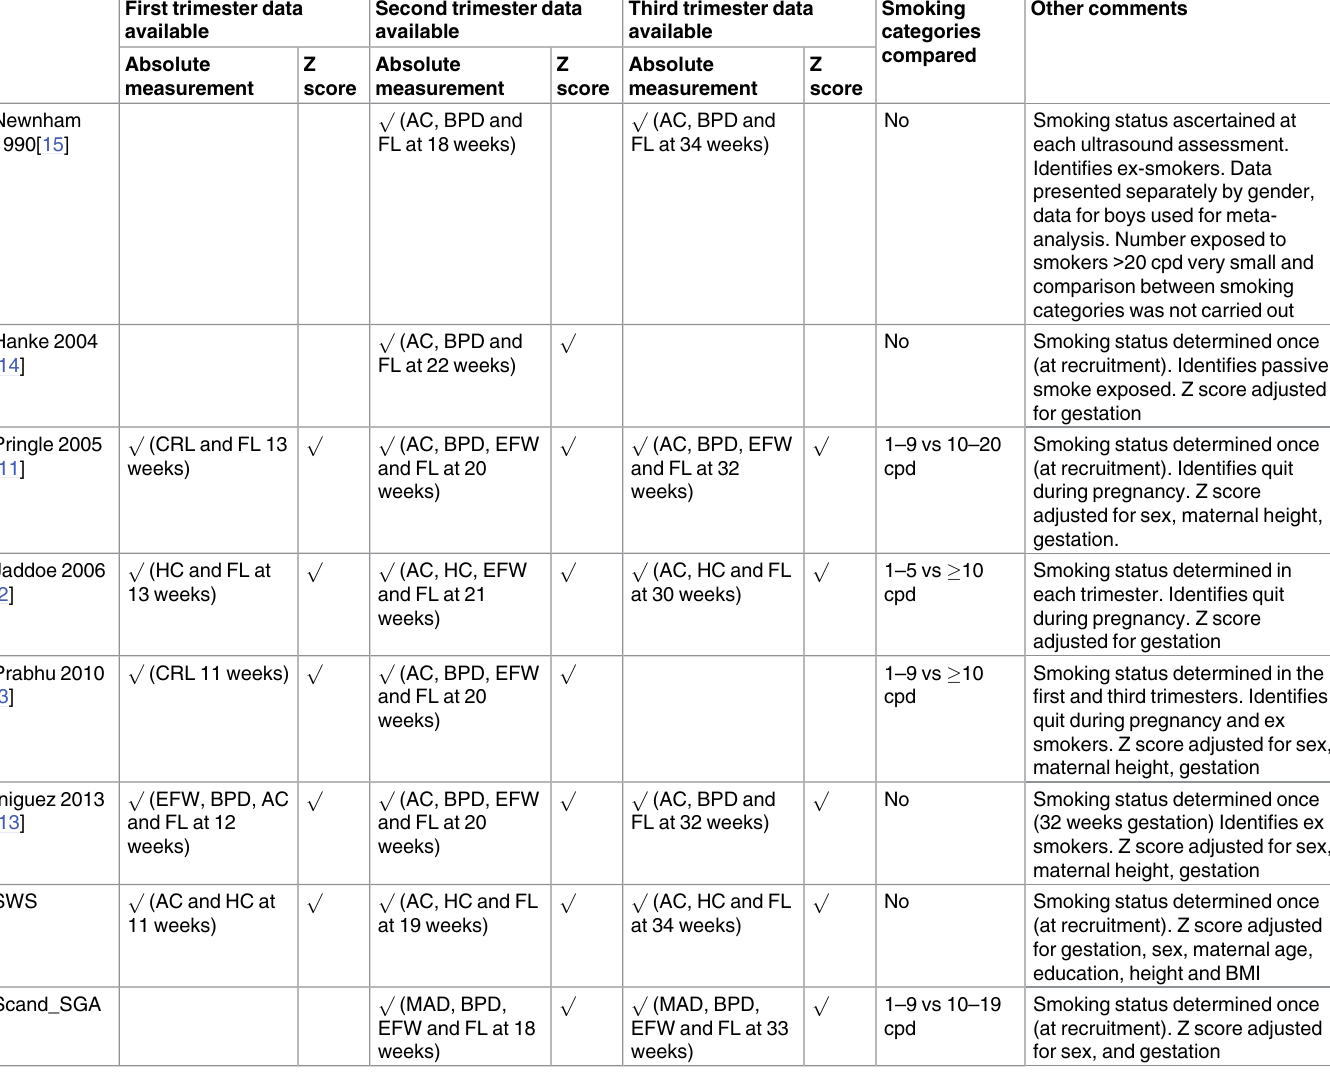
Table 2. Details available from the studies used in the meta-analysis of the association between maternal smoking status and fetal ultrasound measurements. First trimester data